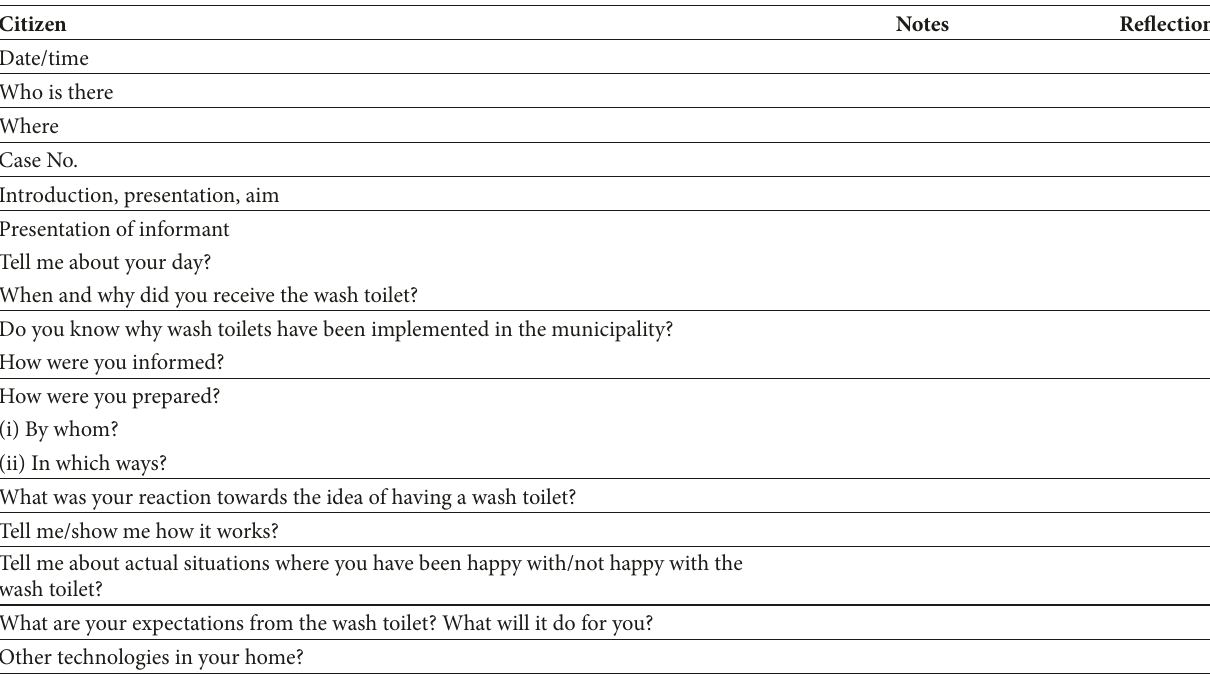
Table 1: Interview